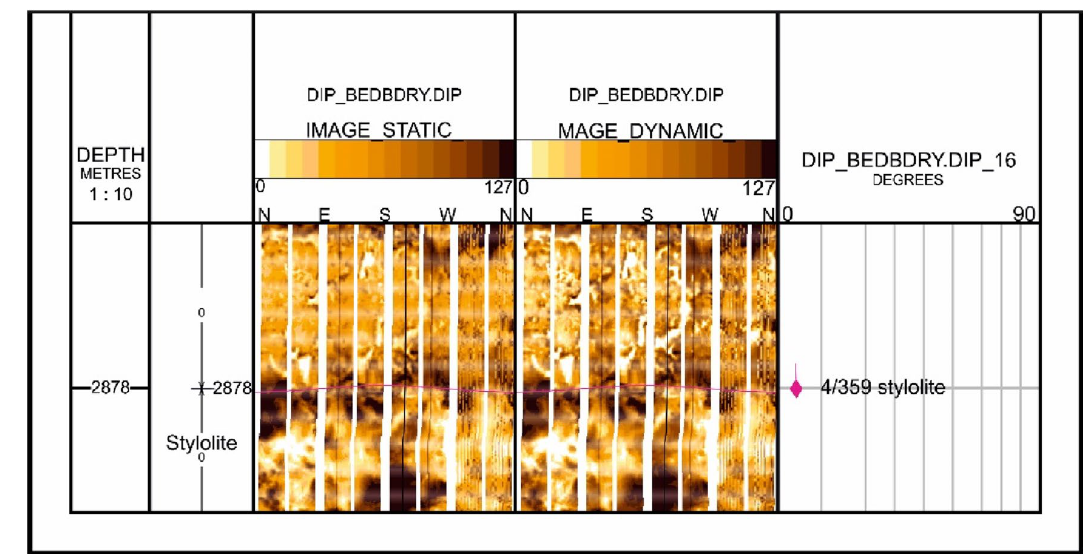
Fig. 10 An image-log example of a stylolite in the studied well (2878 m)